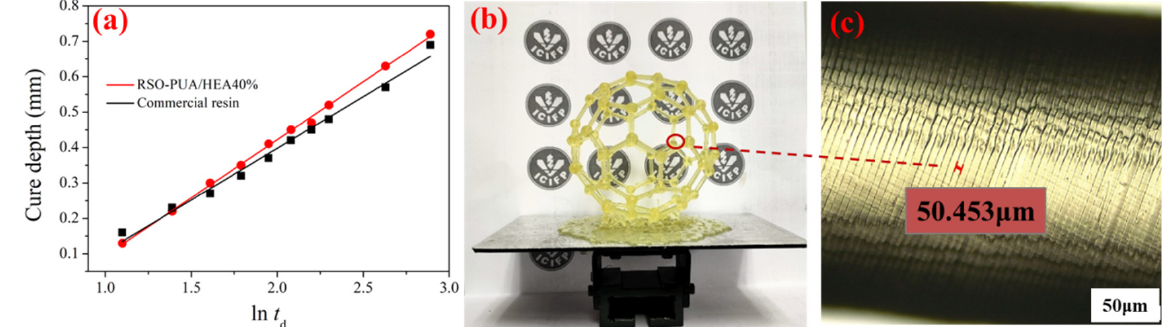
Figure 7. ( a ) Working curves of the UV-curable RSO-PUA/HEA40% resin and commercial resin; ( b ) the printed model of football-ene; ( c ) the surface image of the football-ene model. Table 5. The printing parameters of RSO-PUA/HEA40% resin and commercial resin. Sample